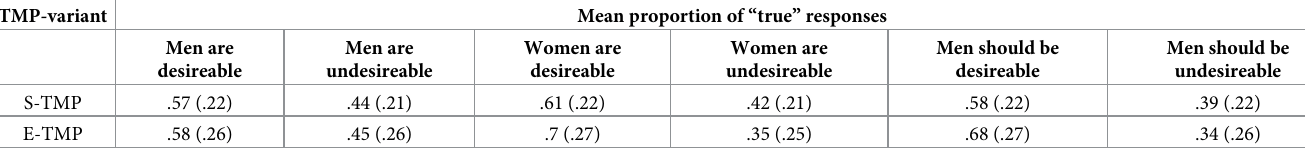
Table 3. Proportions of “true” responses” for each of the beliefs assessed in the TMP in Experiment 3.